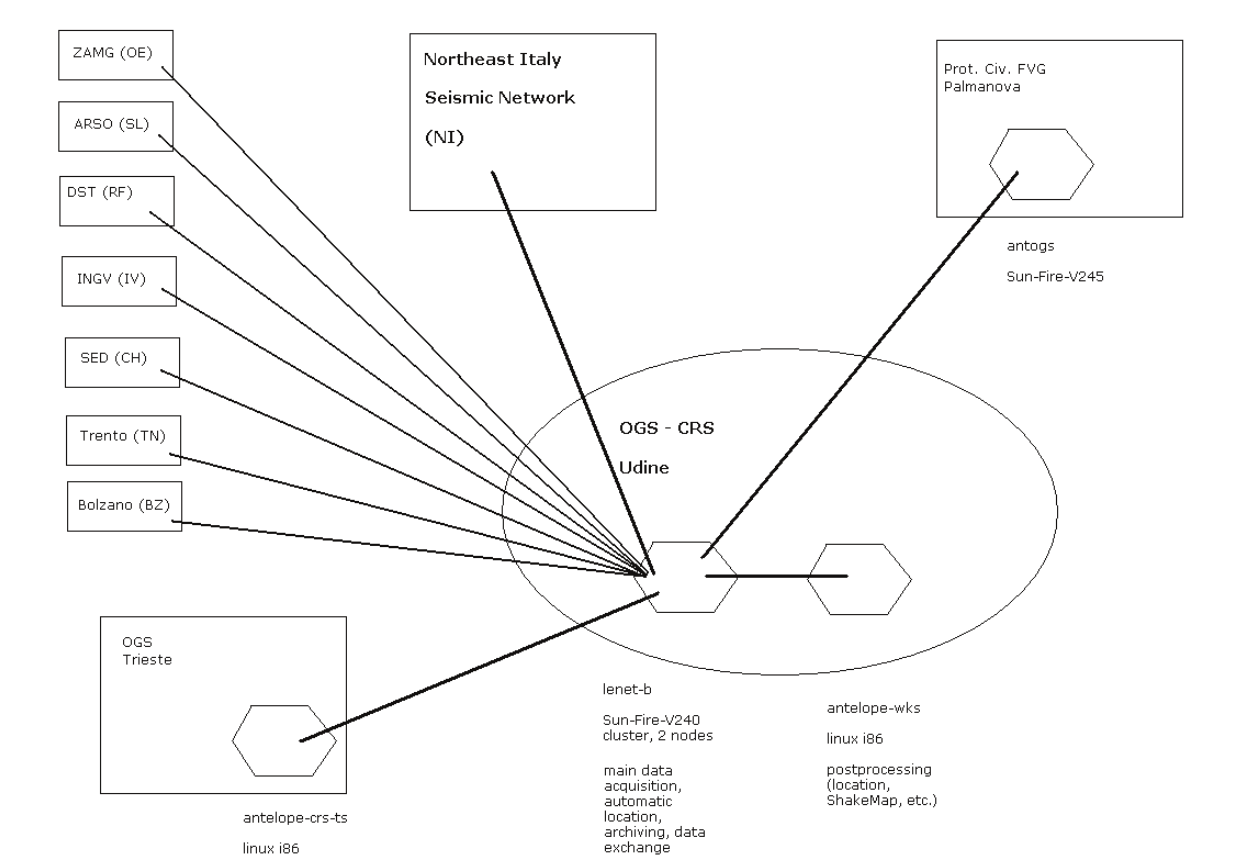
Figure 3. Antelope-based architecture implemented at the